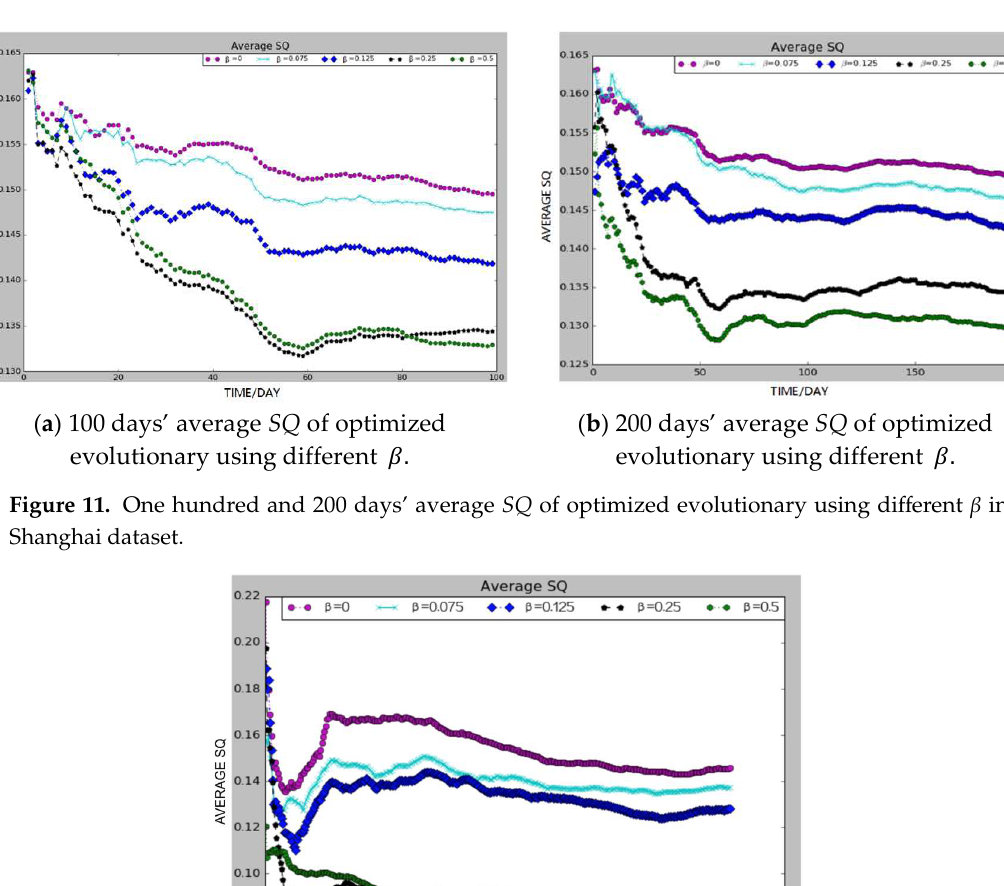
Figure 13. One hundred days’ and 150 days’ average HQ of optimized evolutionary using different 𝛽 in Shanghai dataset. Figure 14. One-year average SQ of optimized evolutionary using different 𝛽 in LD2011_2014 dataset. 6.4. Adjusting Optimal 𝛽 To comprehensively demonstrate the optimal 𝛽 when applying the optimized algorithm, a weighted sum of SQ and HQ (WSeH), is used as the evaluation indicator of choosing the optimal 𝛽 . From the beginning, we have emphasized that maximizing two conflict measurements SQ and HQ is our goal, and the indicator, WSH, is the concrete goal.